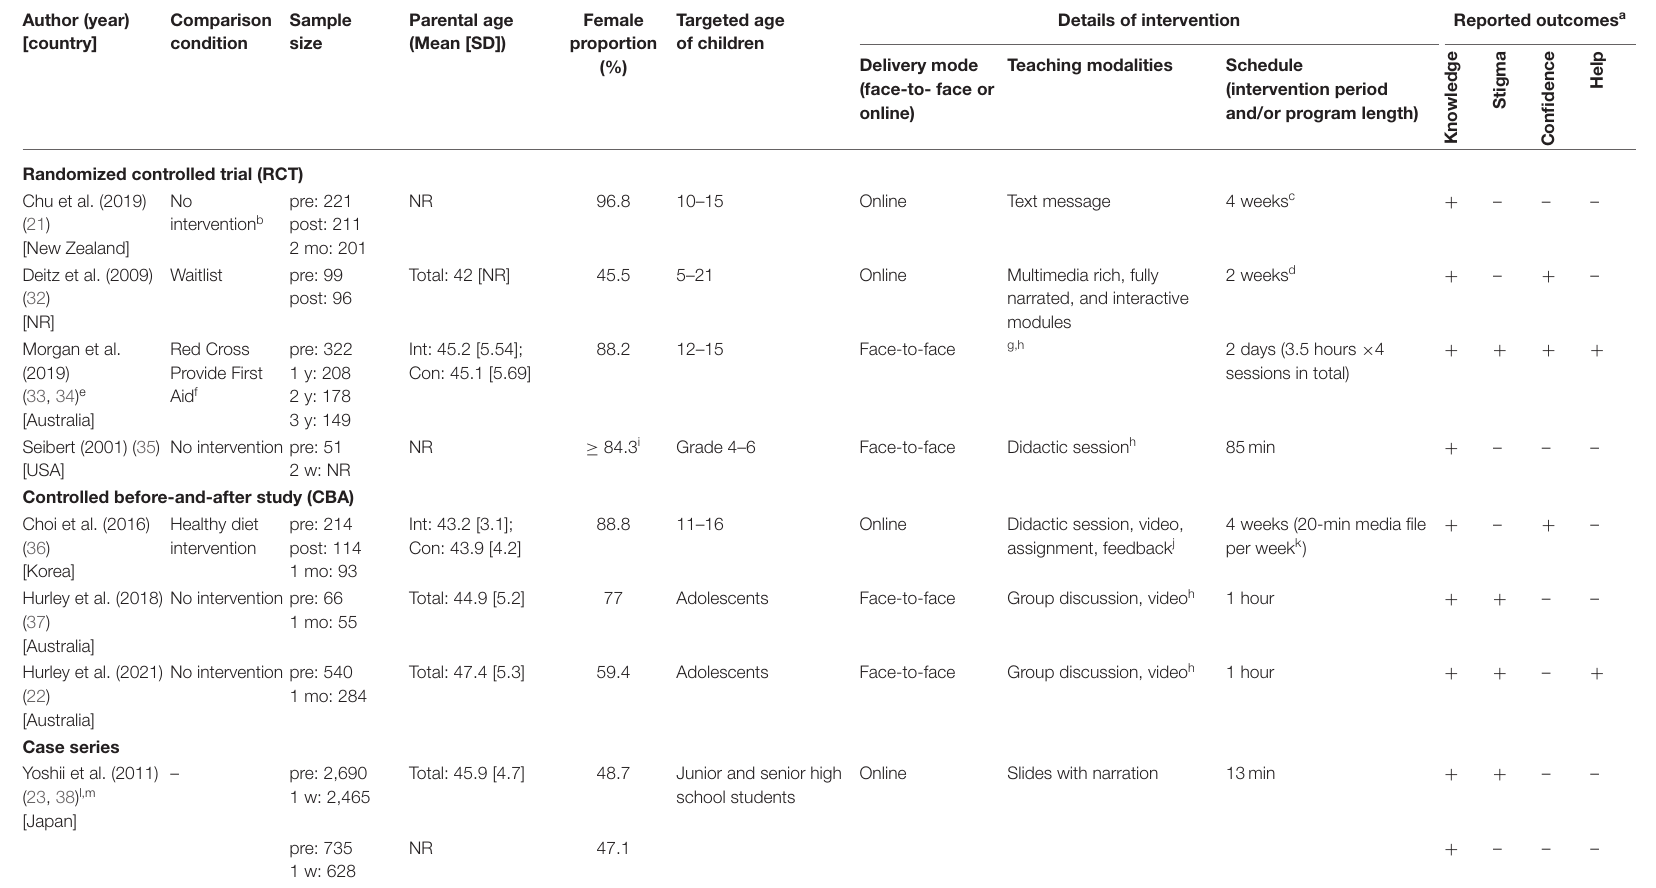
TABLE 1 | Characteristics of included